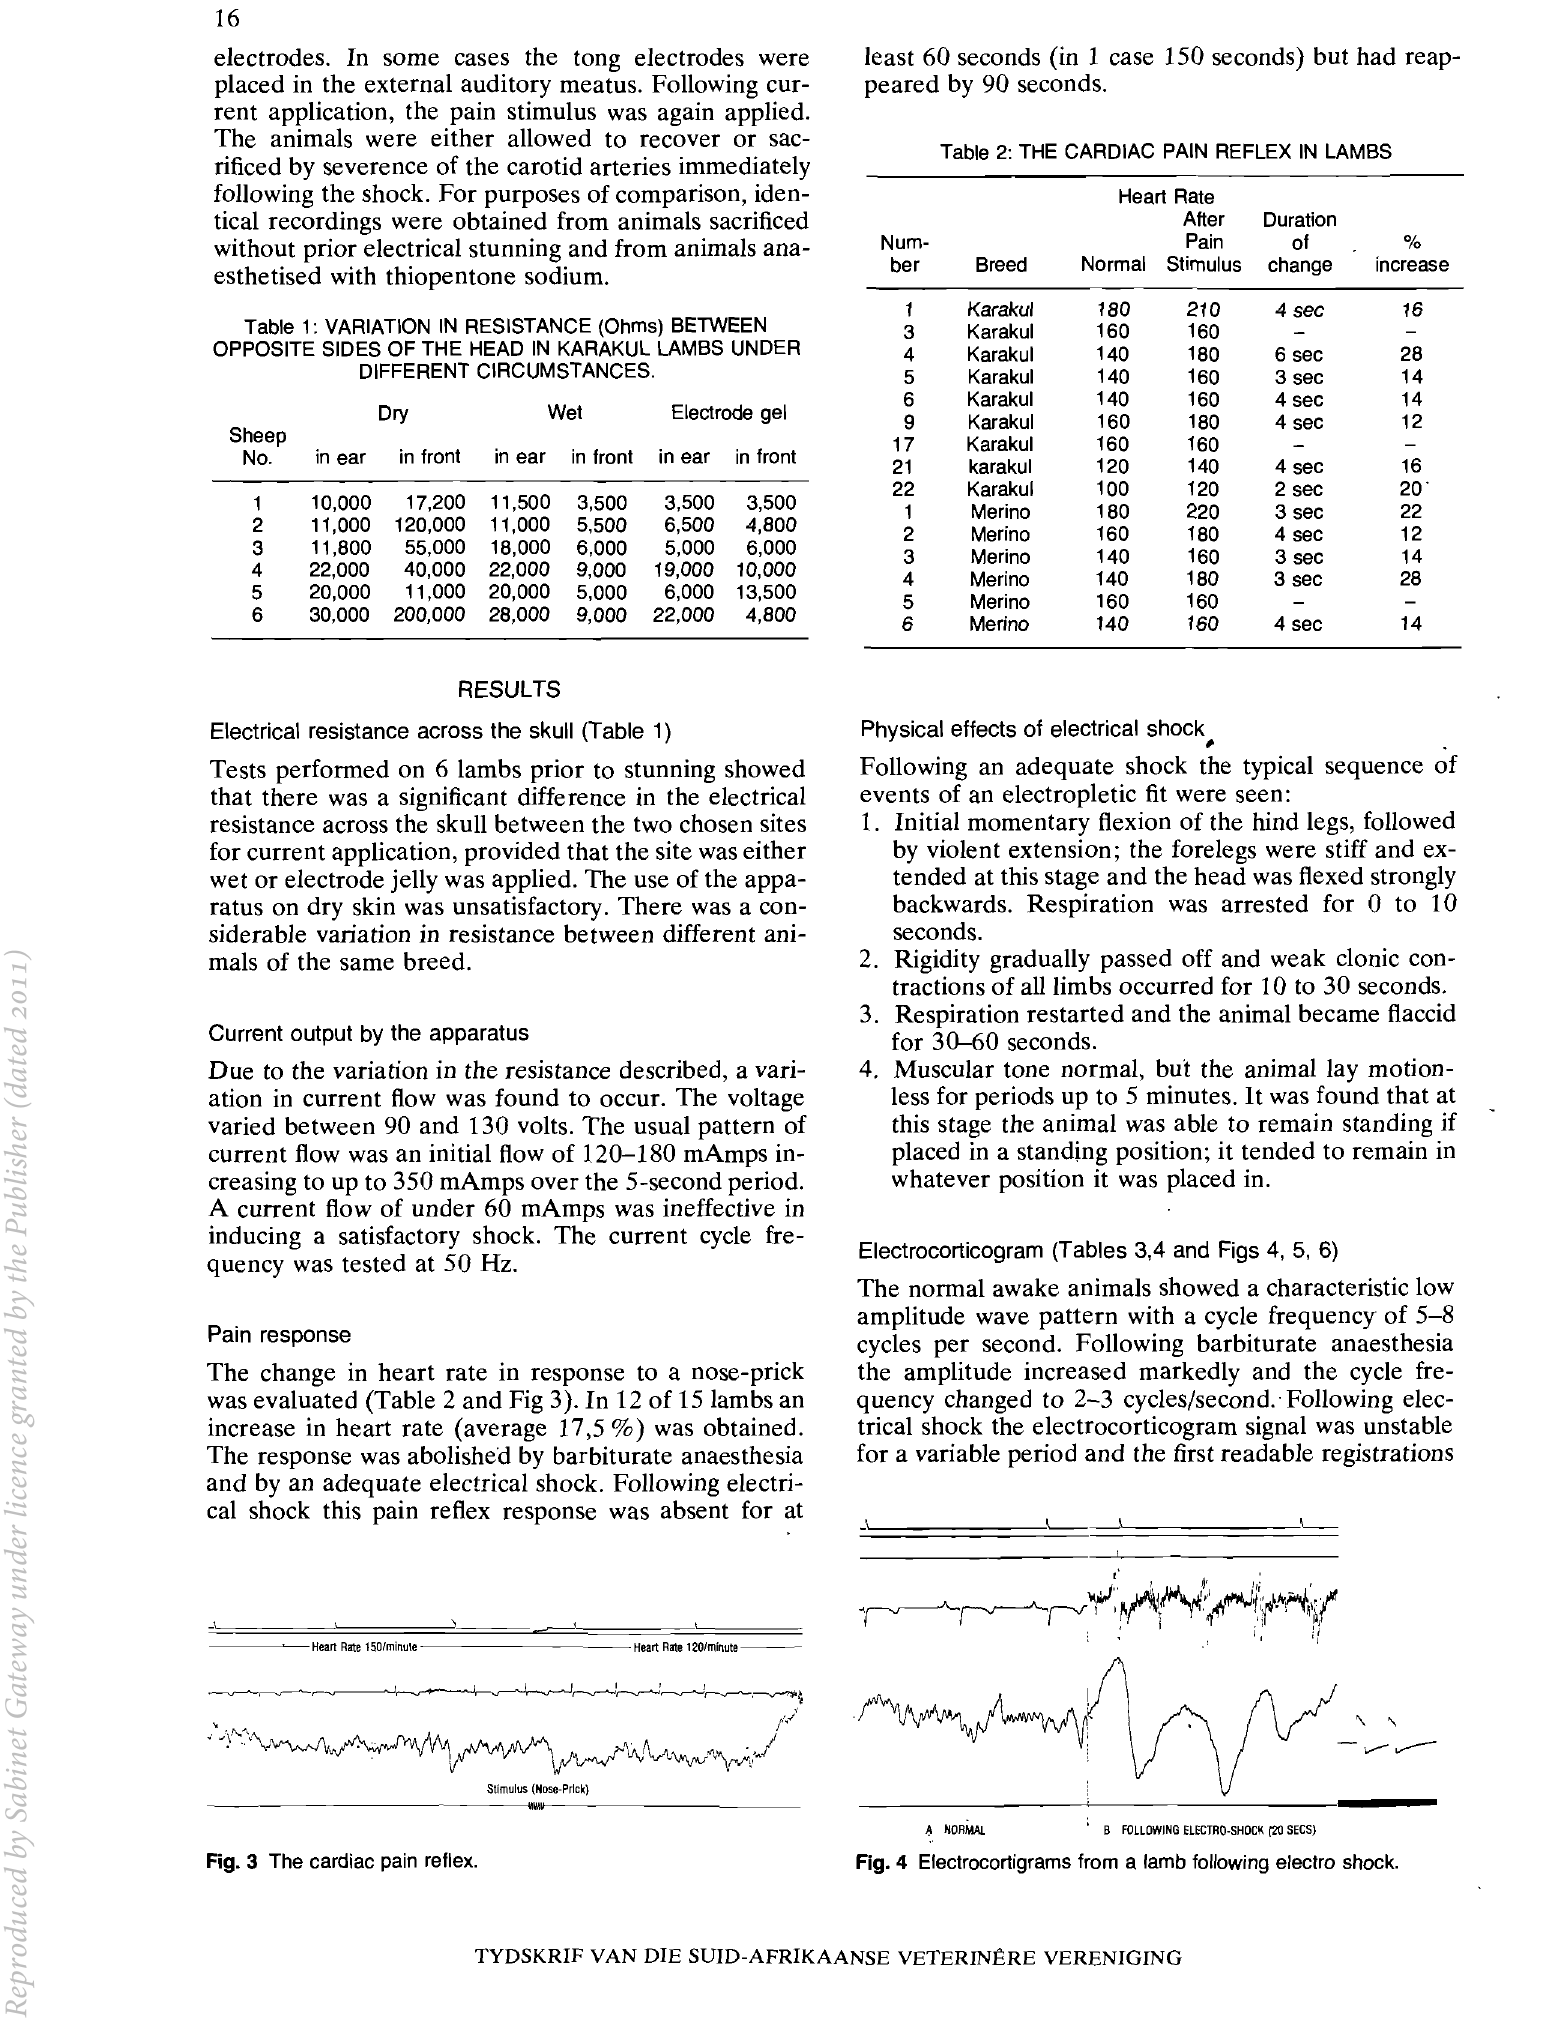
Table 1: VARIATION IN RESISTANCE (Ohms) BETWEEN OPPOSITE SIDES OF THE HEAD IN KARAKUL LAMBS UNDER DIFFERENT CIRCUMSTANCES. Dry Wet Electrode gel Sheep